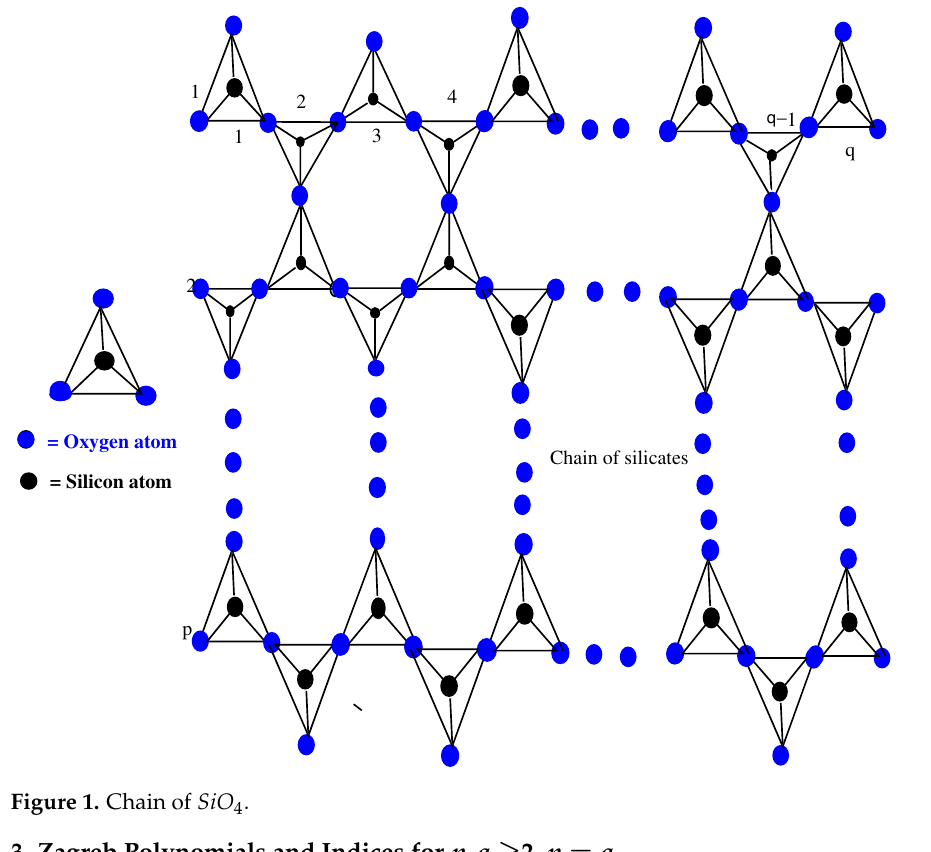
Figure 1. Chain of SiO 4